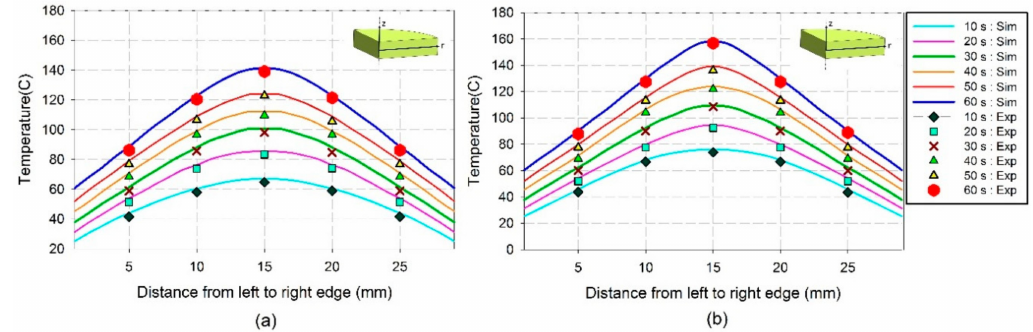
Figure 9. Temperature at di ff erent distances; ( a ) unripe bananas; ( b ) ripe